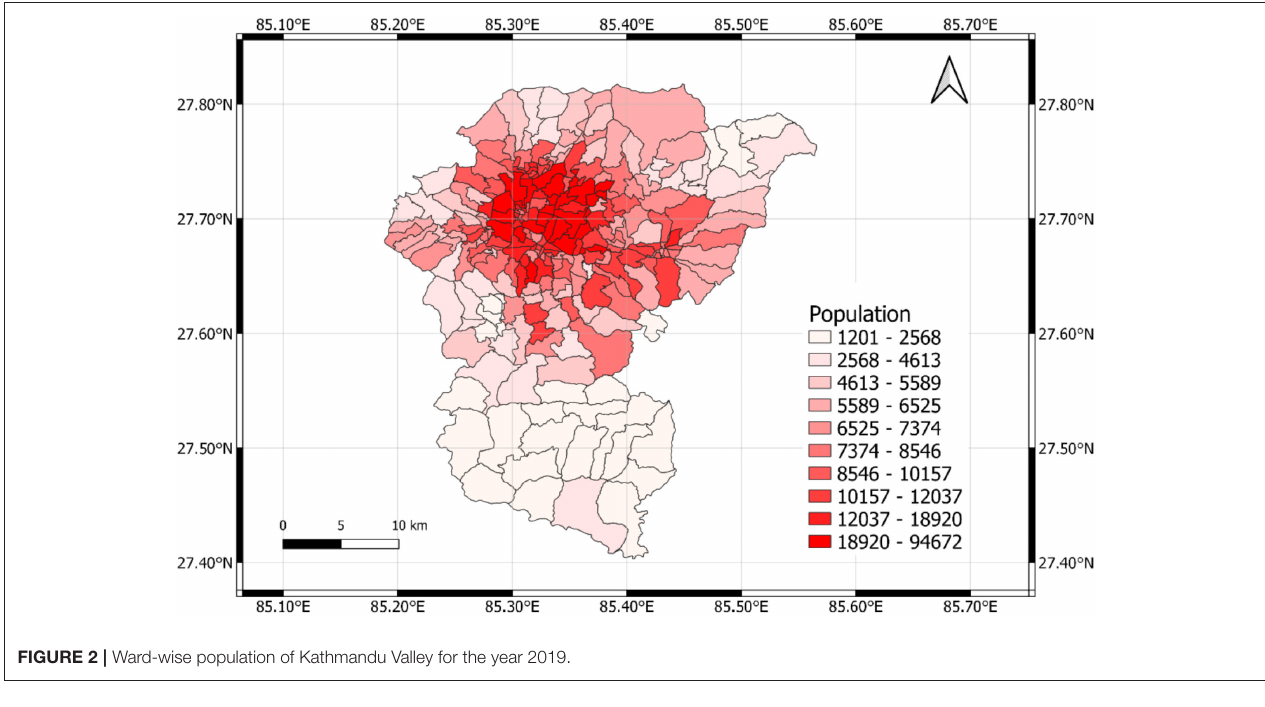
FIGURE 2 | Ward-wise population of Kathmandu Valley for the year 2019.